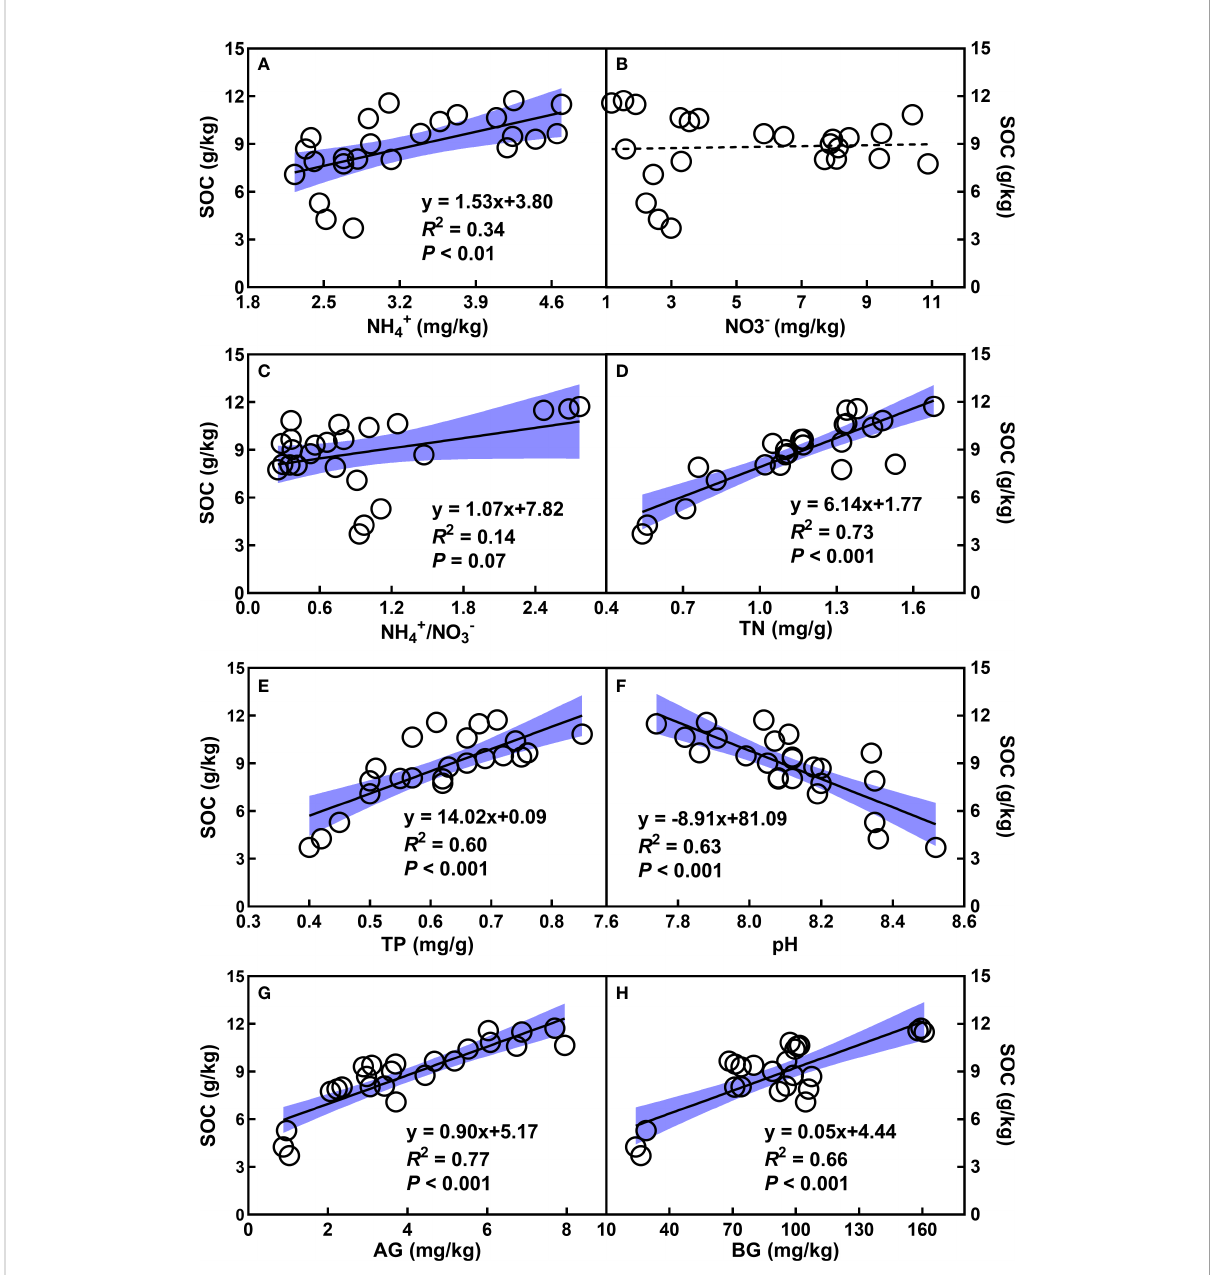
FIGURE 3 Relationships of SOC (g/kg) with NH 4+ (A) , NO 3- (B) , the ratio of NH 4+ to NO 3- (C) , TN (D) , TP (E) , pH (F) , AG (G) , and BG (H) , respectively. The shadow areas represent 95% con fi dence intervals. See Table 1 for